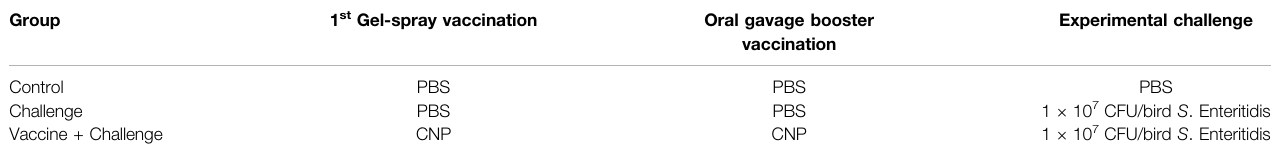
TABLE 1 | Summary of experimental treatment groups. For all experimental groups, the experimental unit was the pen, n = 6 pen/treatment, with 16 technical replicates as birds/pen. For the gel-spray vaccination, 2 mg of CNP vaccine was reconstituted in 25 ml of Gel-Pac solution and sprayed on 100 chicks. For the mock gel-spray vaccination,PBS(pH7.4)wasaddedtotheGel-pacstocksolution.Fortheoralgavageboostervaccination,birdsintheexperimentalgroupweregiven20 μ gCNP/bird,and birds in the control groups were given 0.5 ml PBS/bird. At d14 of age birds in the negative control group were given a mock challenge of 0.5 ml PBS/bird and birds in the positive control and the treatment group were orally challenged with 1 × 10 7 CFU/bird of S. Enteritidis (nalidixic acid-resistant). Group 1 st Gel-spray